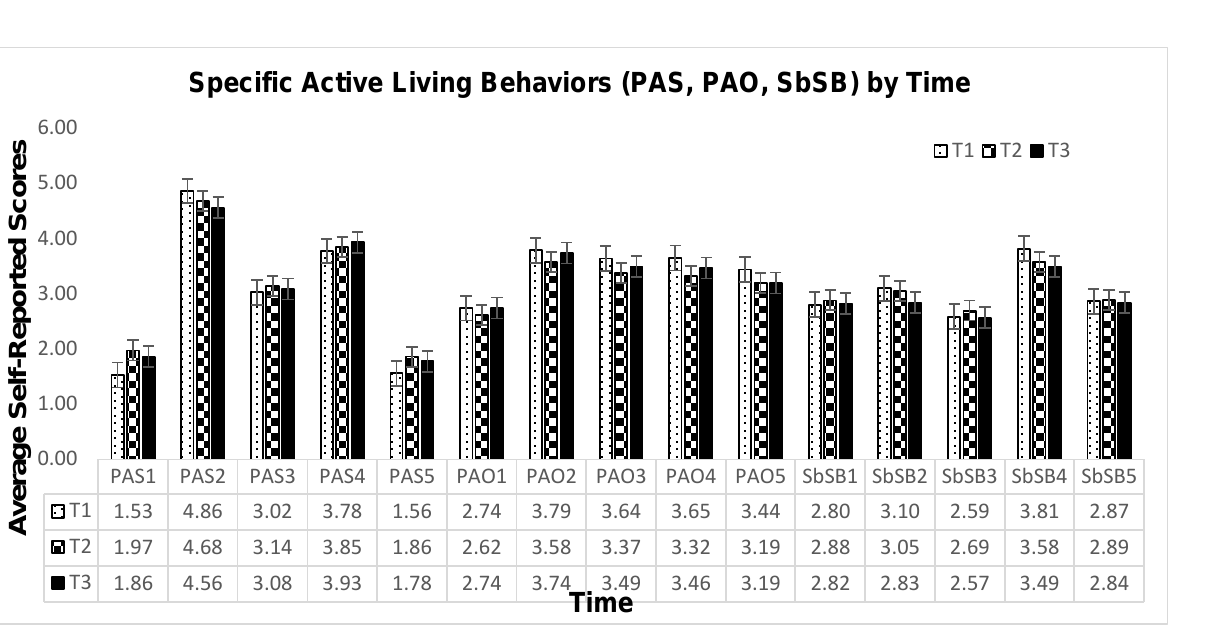
Figure 1. The average levels of specific active living behaviors at each time point. PAS: physical activity at school; PAO: physical activity out of school; SbSB: screen-based sedentary behavior. PAS1–PAS5: walk/bike to school, PE, breaks/study hall, lunch break, walk/bike from school; PAO1–PAO5: before school, after school, school day evening, Saturday, Sunday; SbSB1–5: viewing TV, playing video games, using computers, using cellphones, sitting habits. T1 = January 2020; T2 = February 2021; T3 = March